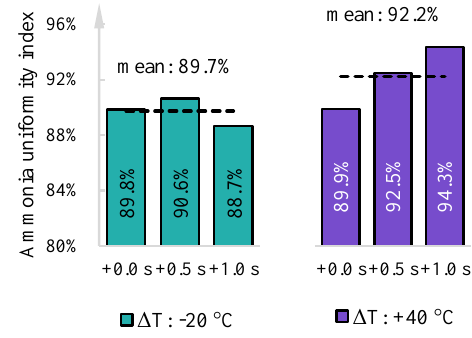
Fig. 8. Ammonia uniformity index at a gas mass flow rate of 100 kg/h, all subcases listed